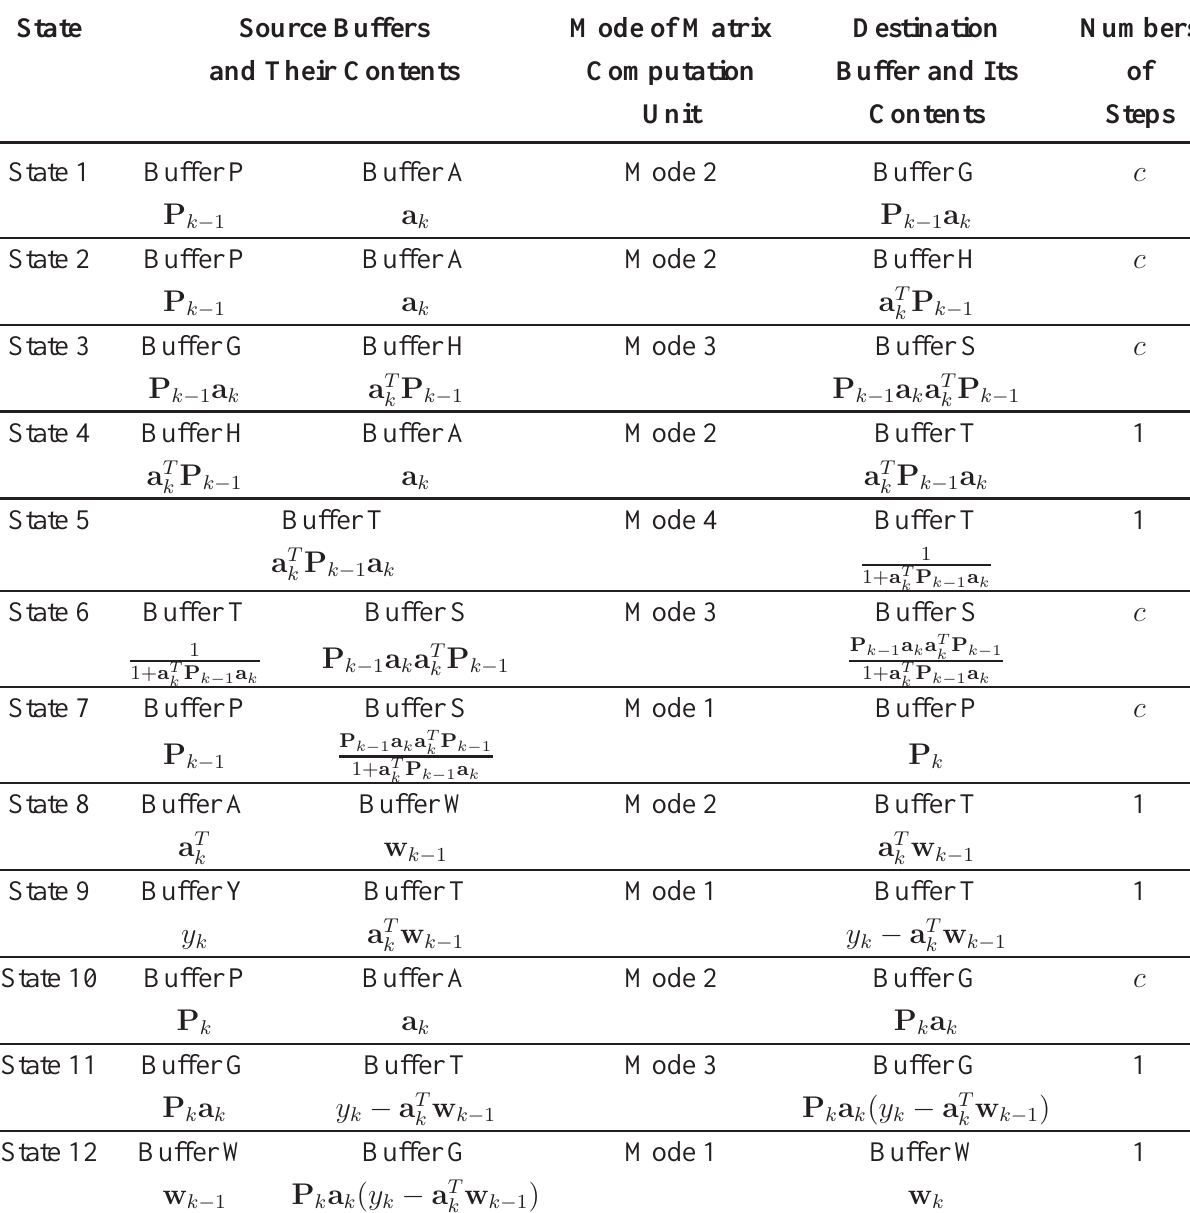
Table 2. The operations of state 1 to state